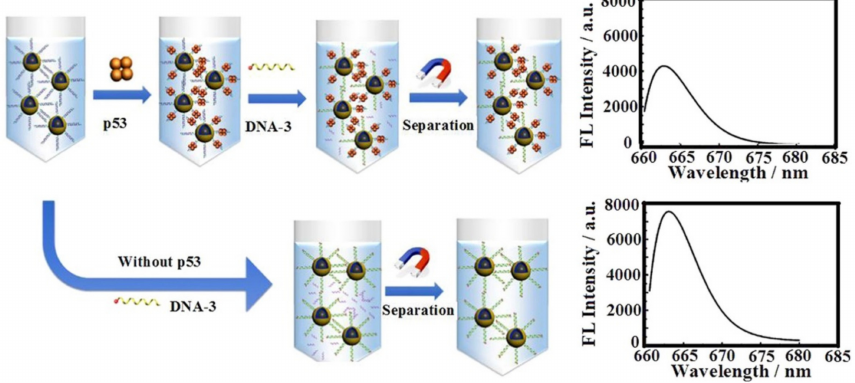
Figure 6. A fluorescent sensor for p53 protein expression was developed by combination of functional consensus DNA and magnetic nanoparticles. The sensor can realize ultrasensitive detection of p53 protein in real cell lysate. Reprinted from [76] with permission of Elsevier provided by Copyright Clearance Center.